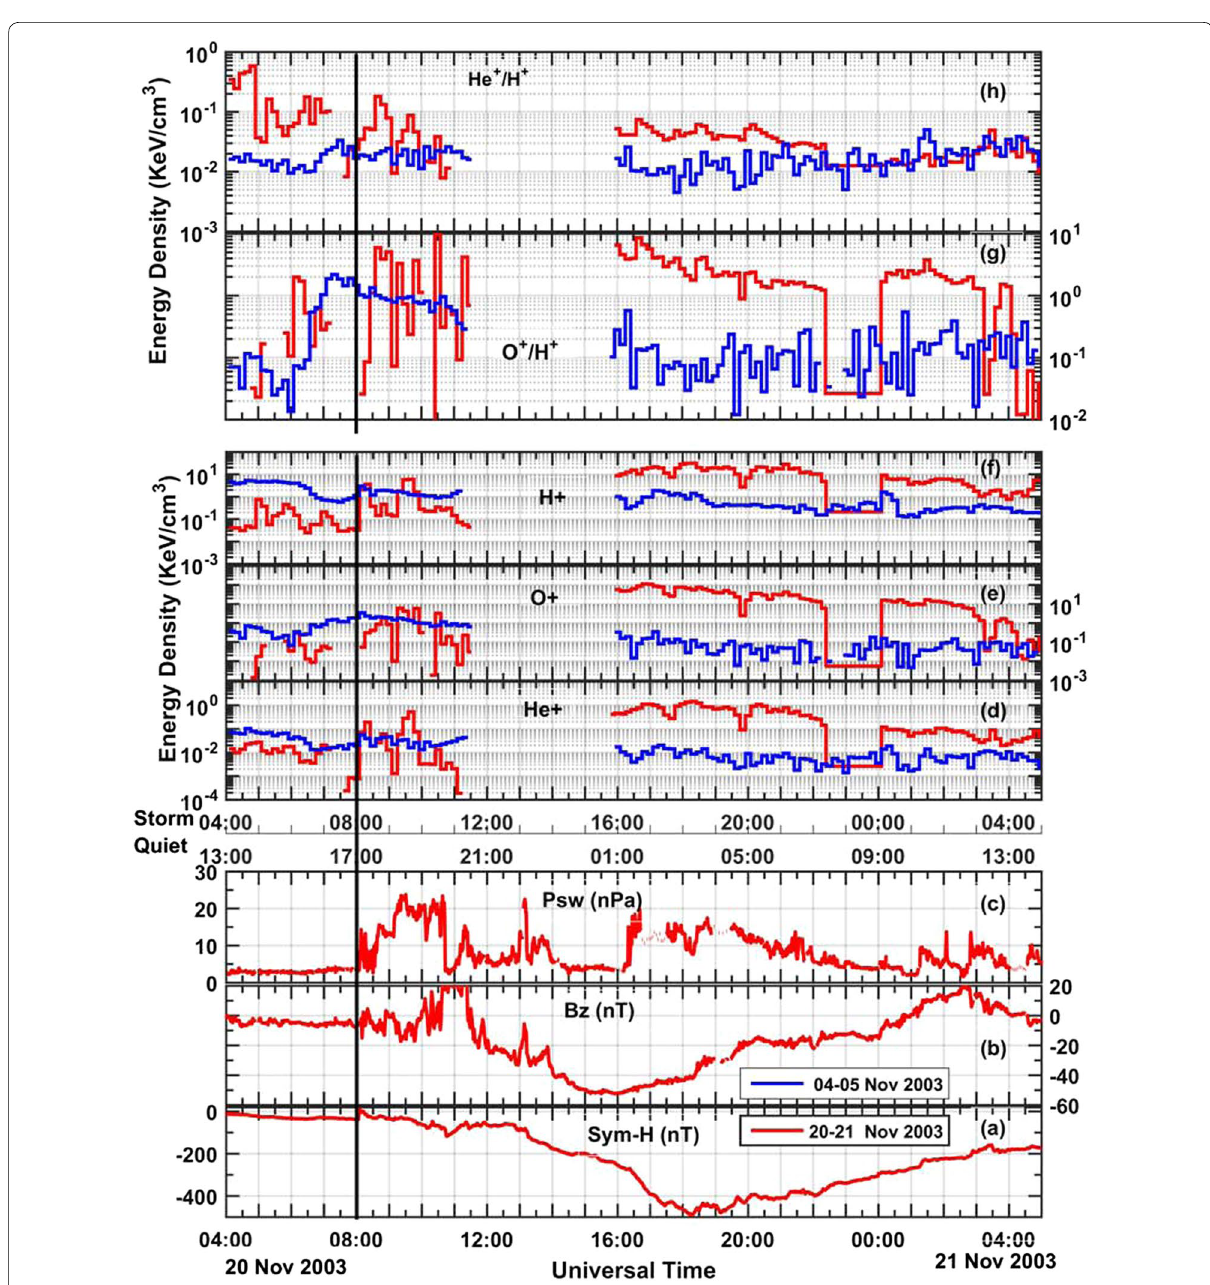
Fig. 1 Geomagnetic storm data from 20 November 2003 0400 UT to 21 November 2003 0500 UT, using Geotail satellite. a Sym-H, b , c interplanetary parameters (IMF Bz, P sw ), d He + , e O + , f H + ions energy density during storm (red) and quiet (blue) intervals, g O + /H + , h He + /H + energy density ratio. The black vertical line shows the time of storm sudden commencement